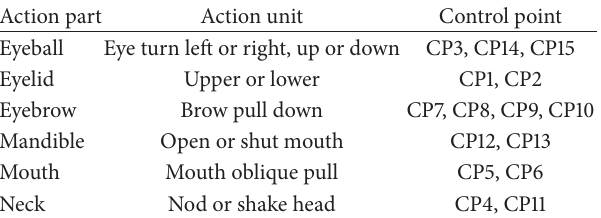
Table 2: Action unit of robot